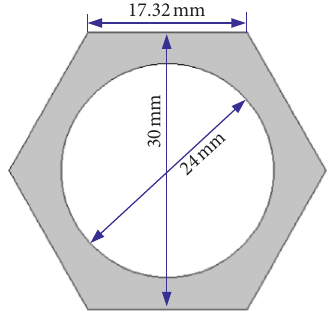
Figure 2: The cross section of a hexagonal